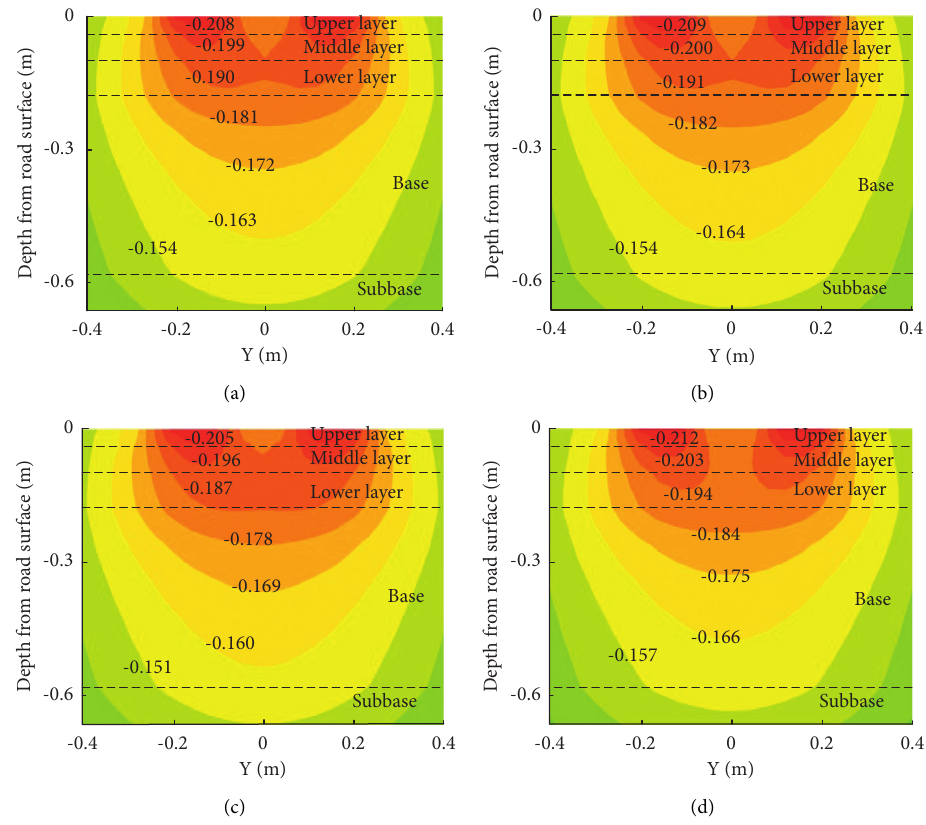
Figure 6: Contours of instantaneous vertical displacement. (a) AC13-MOH. (b) MOH-AC20. (c) MOH-MOH. (d)